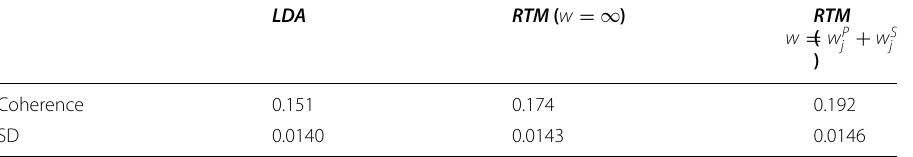
Table 6 Standard deviation for the baseline models and our best model, with respect to the coherence evaluation metric with | T | = 10